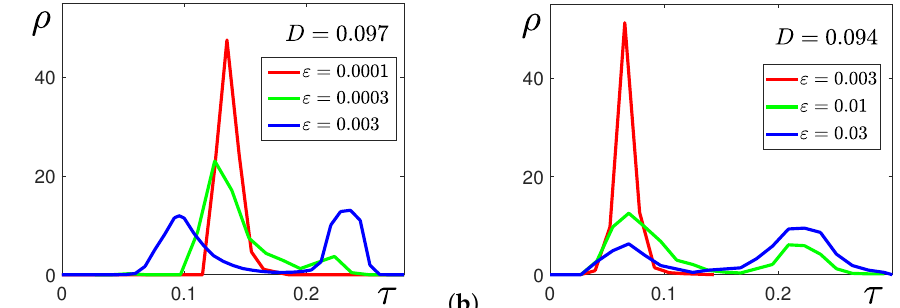
Figure 8. Noise-induced frequency splitting: transformations of the probability density function ρ ( τ ) for ( a ) D = 0.097 and ( b ) D =